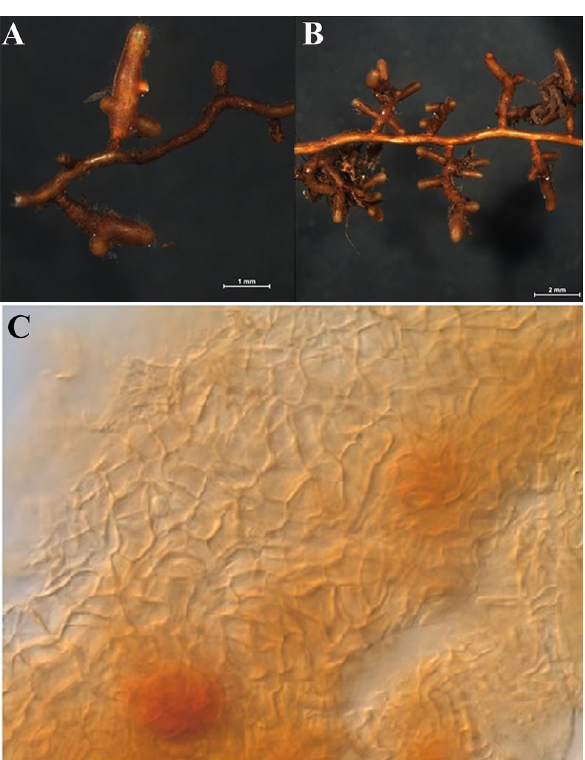
Figure 3. Tuber aestivum root tips under dissecting microscope ( A , B ) and root tip outer-middle mantle under microscope ( C